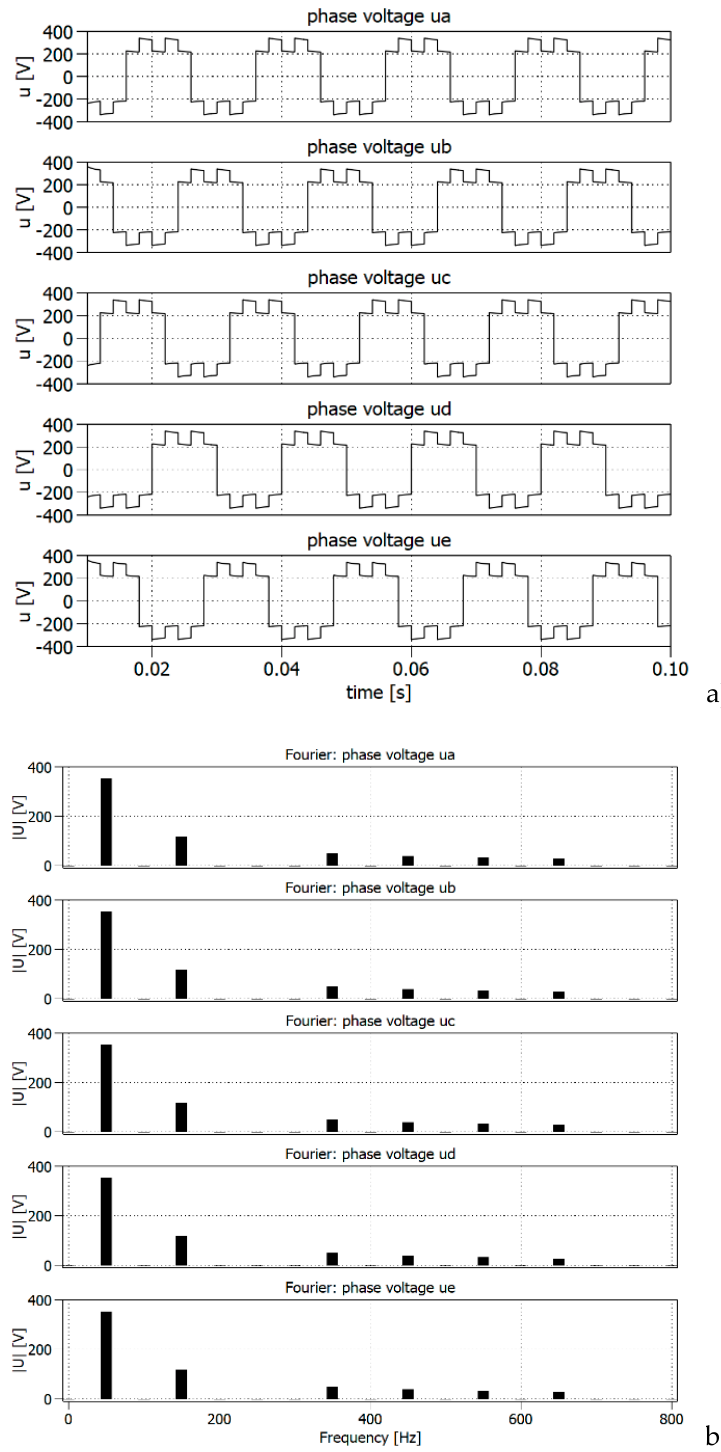
Figure 15. The phase voltages: u a , u b , u c , u d , u e , where: ( a ) voltages waveforms and ( b ) voltages spectra.